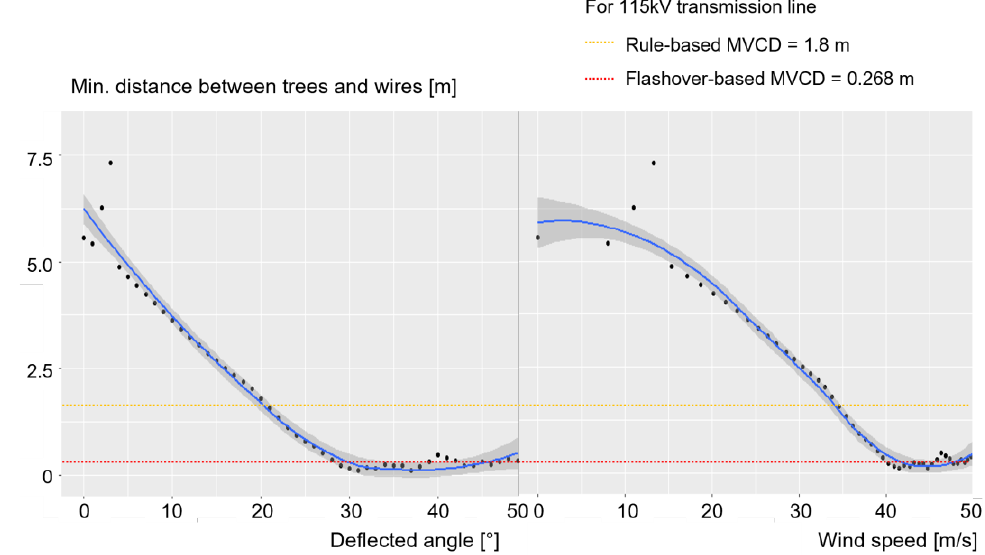
Figure 8. The relationships between the deflected angle of the tree and the minimum distance between trees and wires.